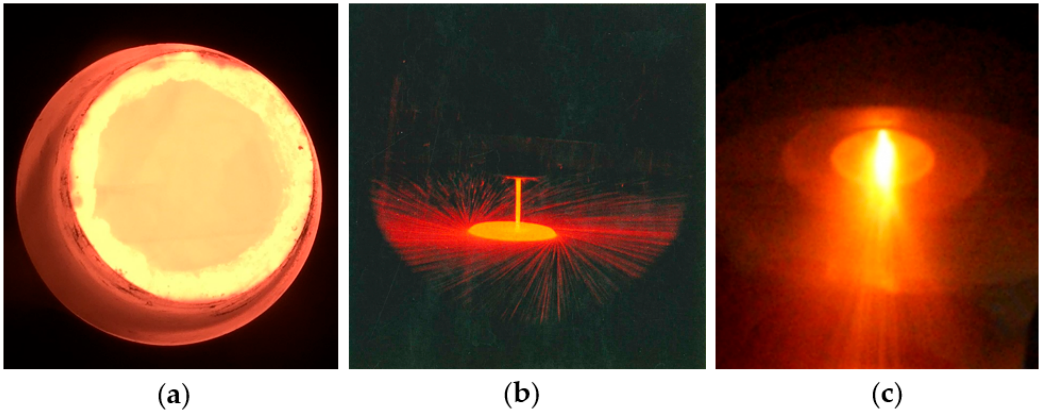
Figure 5. Images during operation of ( a ) a VIM, ( b ) a centrifugal casting (CC), ( c ) a gas atomization (GA) (Courtesy of Daido Steel, Nagoya, Japan).